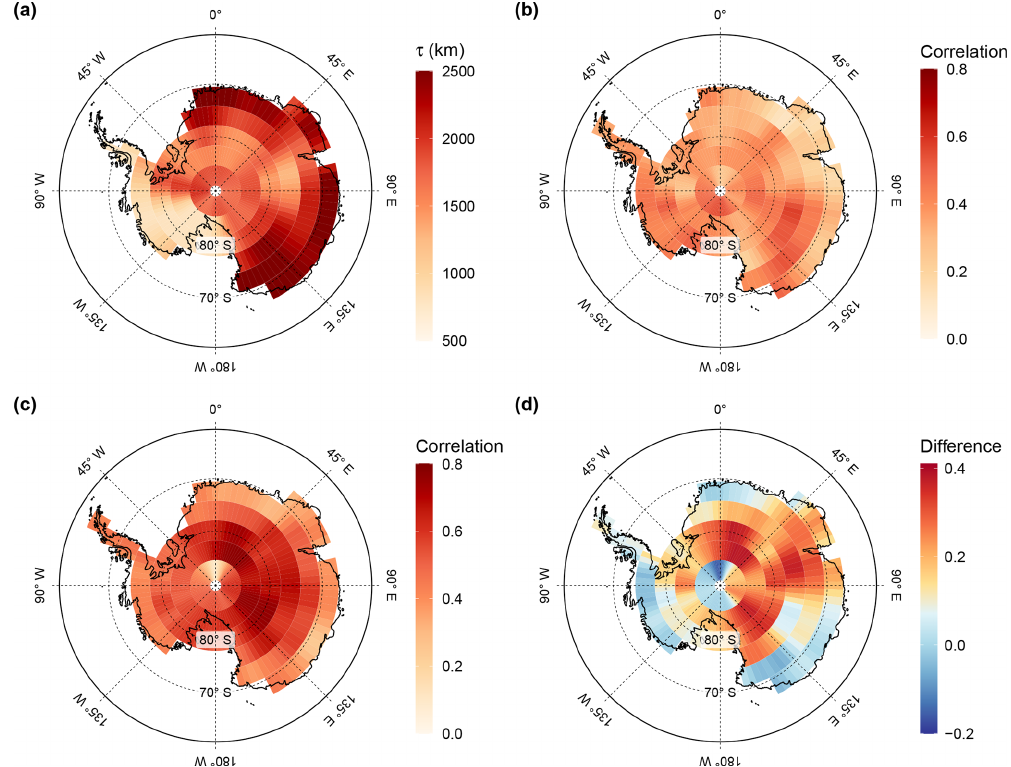
Figure 2. Temperature decorrelation lengths and local temperature–isotope relationship across Antarctica. ( a ) The temperature decorrelation lengths ( τ , in kilometres) for each Antarctic model grid cell estimated by fitting an exponential model to the correlation–distance relationship (see Eq. A4) obtained from correlating the local annual near-surface T 2m time series with the respective temperature time series from all other grid cells. Note that only the continental grid cells were used for the fit. Although the decorrelation lengths show a strong partition between East and West Antarctica, they are larger than 1000km at most locations. ( b , c ) The local correlations at each model grid cell between the annual time series of precipitation-weighted oxygen isotope composition and of ( b ) near-surface temperature and ( c ) precipitation-weighted near-surface temperature. The difference between the maps ( d ) clearly demonstrates that precipitation intermittency is a major limiting factor for the temperature–isotope relationship.